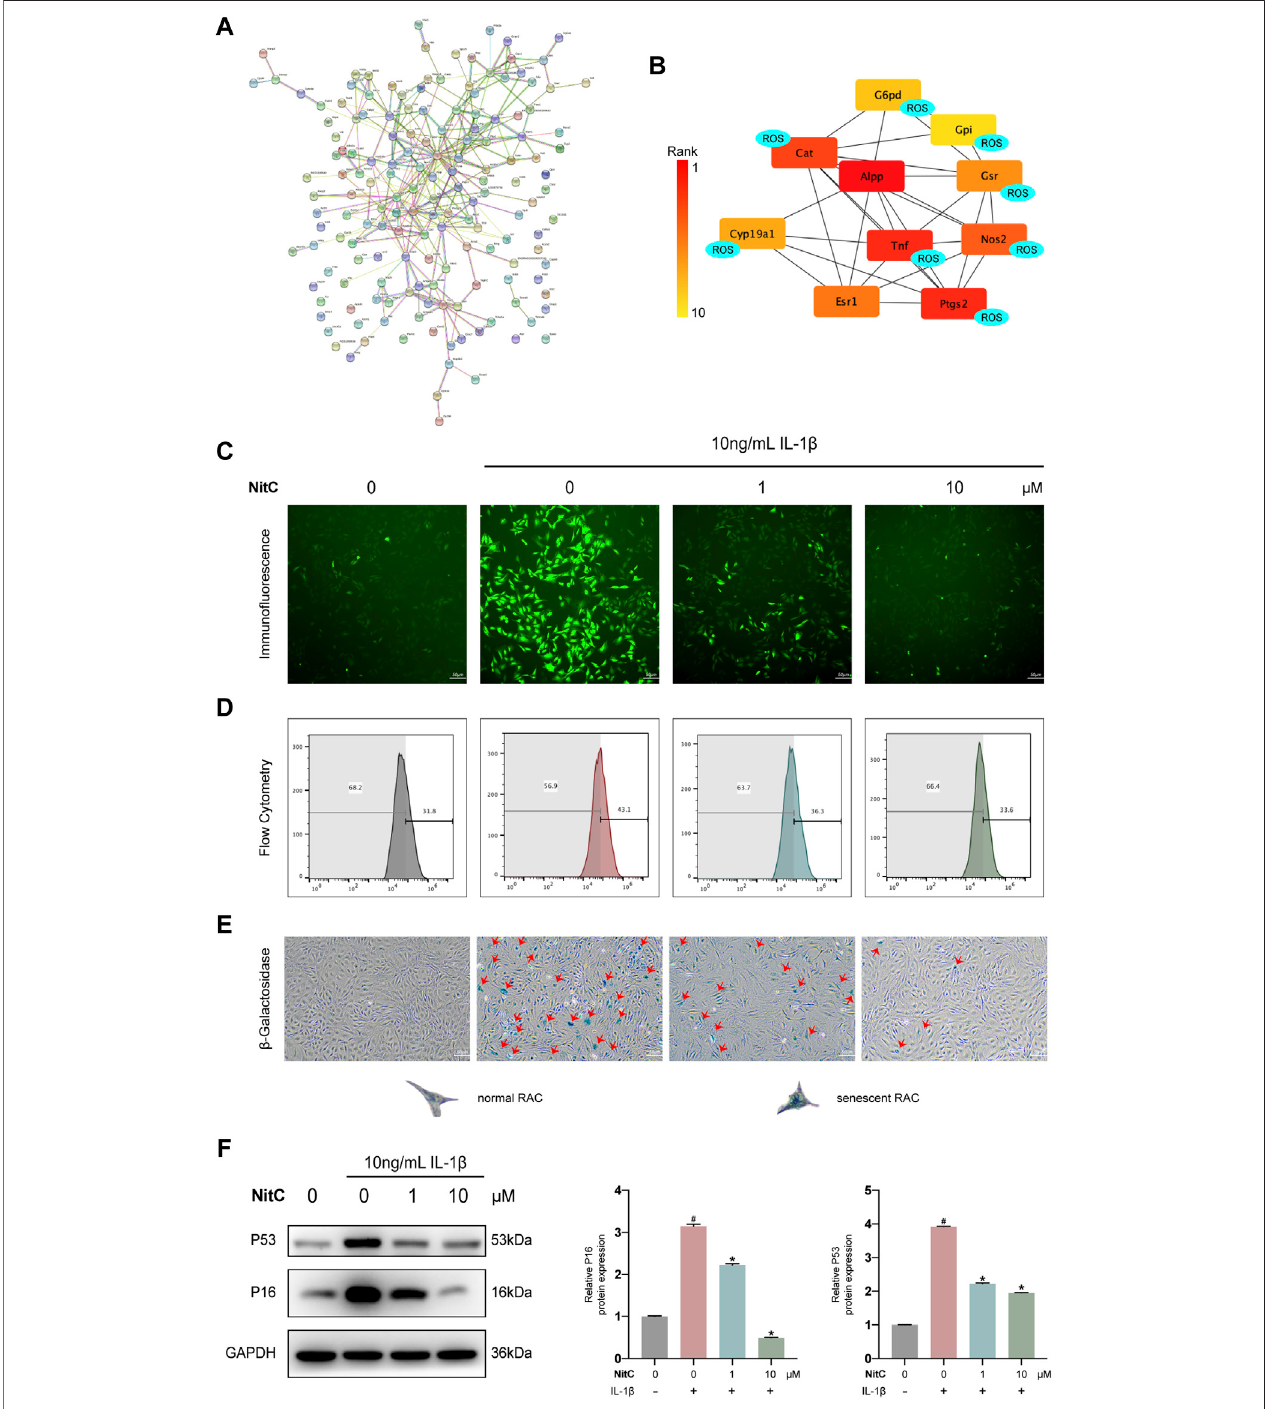
FIGURE 4 | NitC reduced ROS generation and ameliorated cellular senescence in RACs. (A) The potential targets of NitC were obtained by PharmMapper. The protein-protein association network of the targets was established by STRING. (B) The top 10 hub genes were calculated by Cytoscape subsequently. Genes marked with “ ROS ” are involved with the modulation of ROS generation according to the existing research. (C) Immuno fl uorescent microscopy was utilized to detect the ROS in RACs. The intensity of fl uorescence represented the relative level of ROS. (D) The ROS levels of different groups were also assessed through fl ow cytometry. (E) β -Galactosidase activity assay was performed in RACs. Typical normal RAC and senescent RAC were shown. Red arrows mark the senescent RAC. (F) The WB analysis of cellular senescence-related genes: p16 and p53 were conducted. Meanwhile, the quanti fi ed results of relative protein expression were present. #p < 0.05 versus the control group. p p < 0.05 versus the model group. Scale bars = 50 μ M.